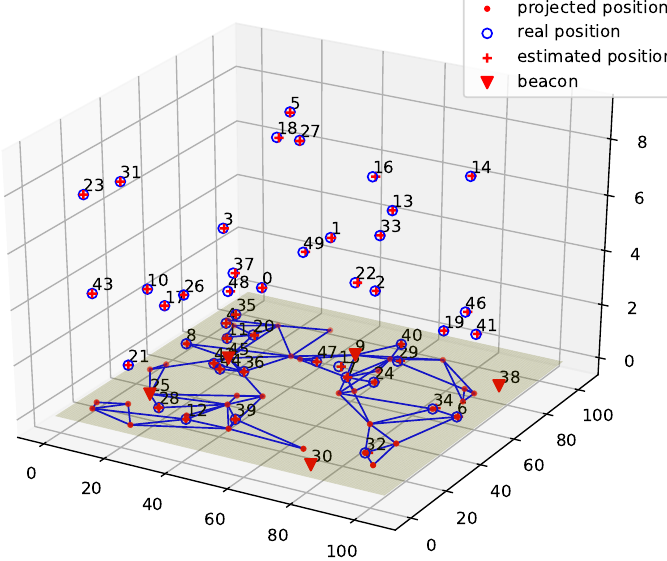
Figure 6. ProLo Localization for a 50-node 5-beacon 3D